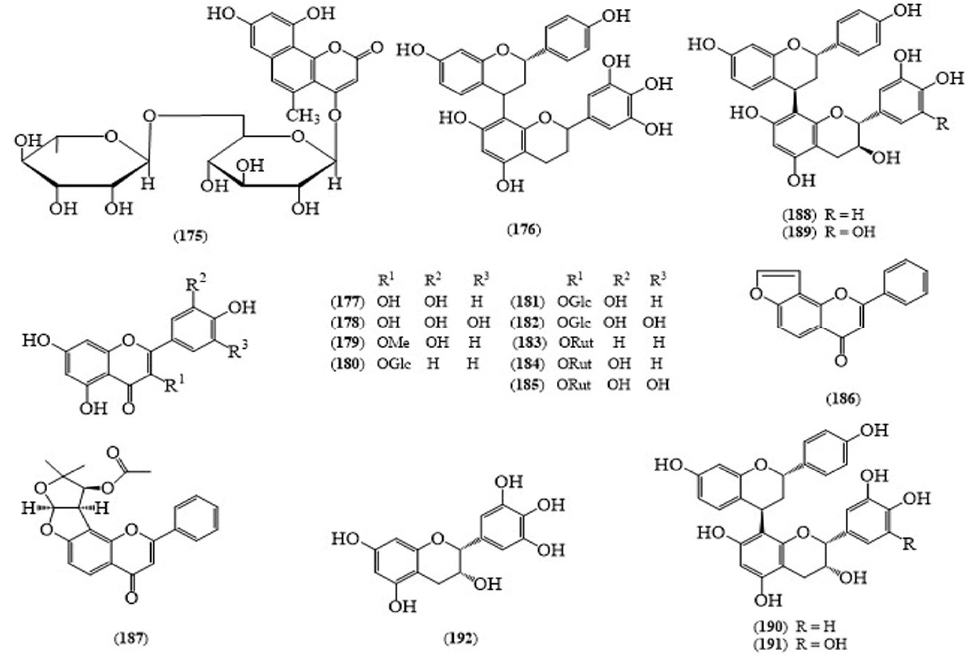
Figure 14. Structures of selected compounds isolated from Cassia auriculata.